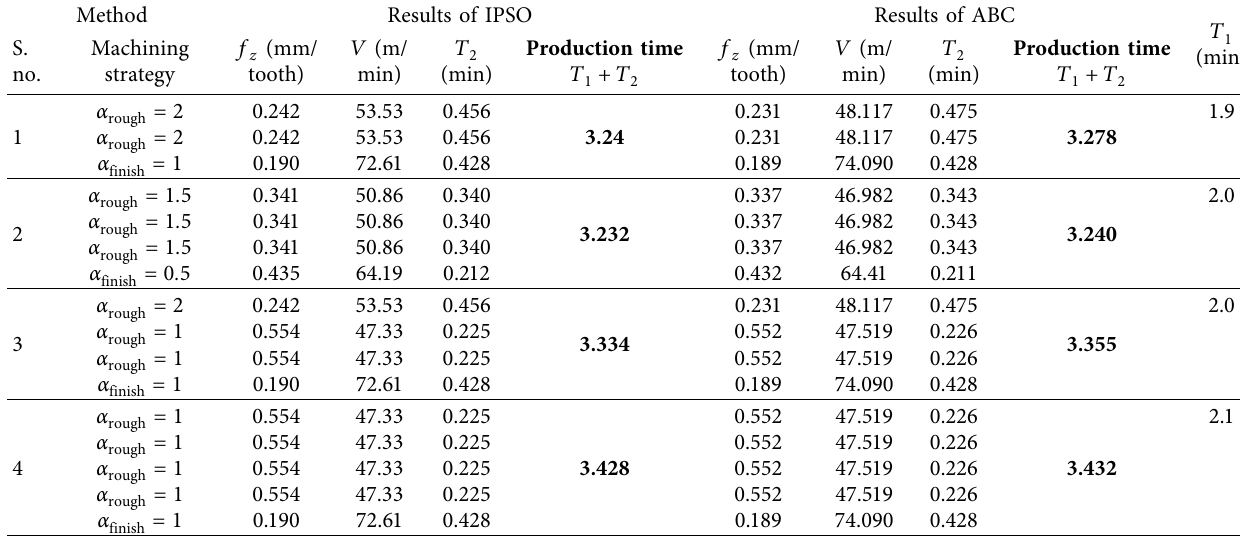
Table 3: Computational results of PSO and ABC.